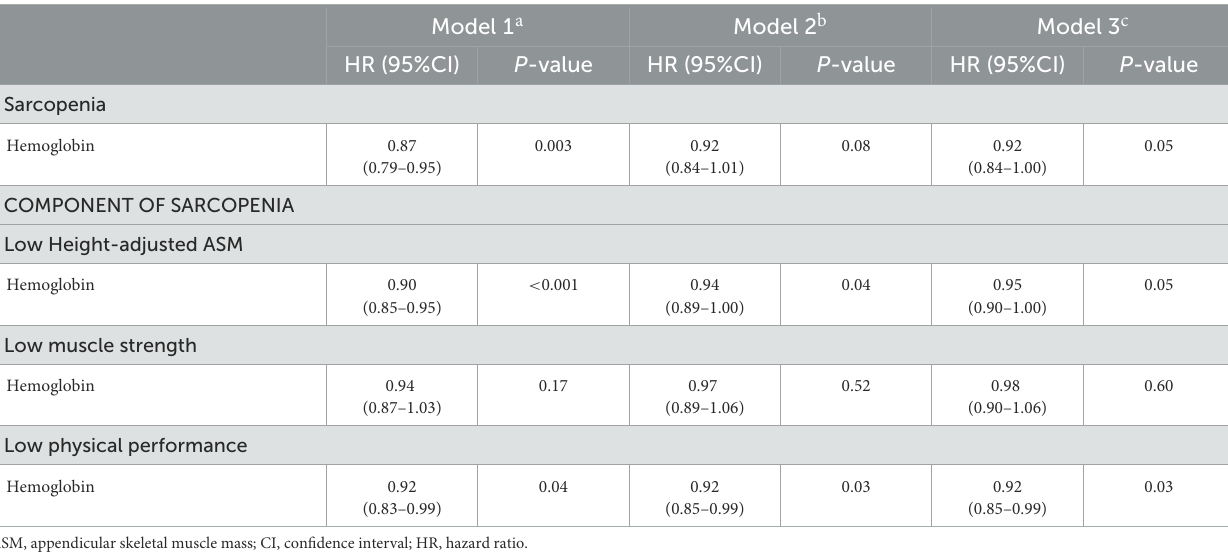
TABLE 3 Longitudinal associations among baseline hemoglobin level, sarcopenia, and sarcopenia components, 2011–2015.